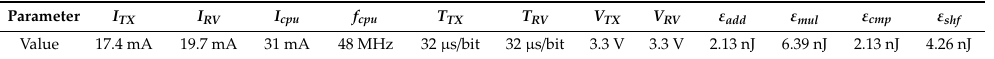
Table 2. Parameters to evaluate the energy